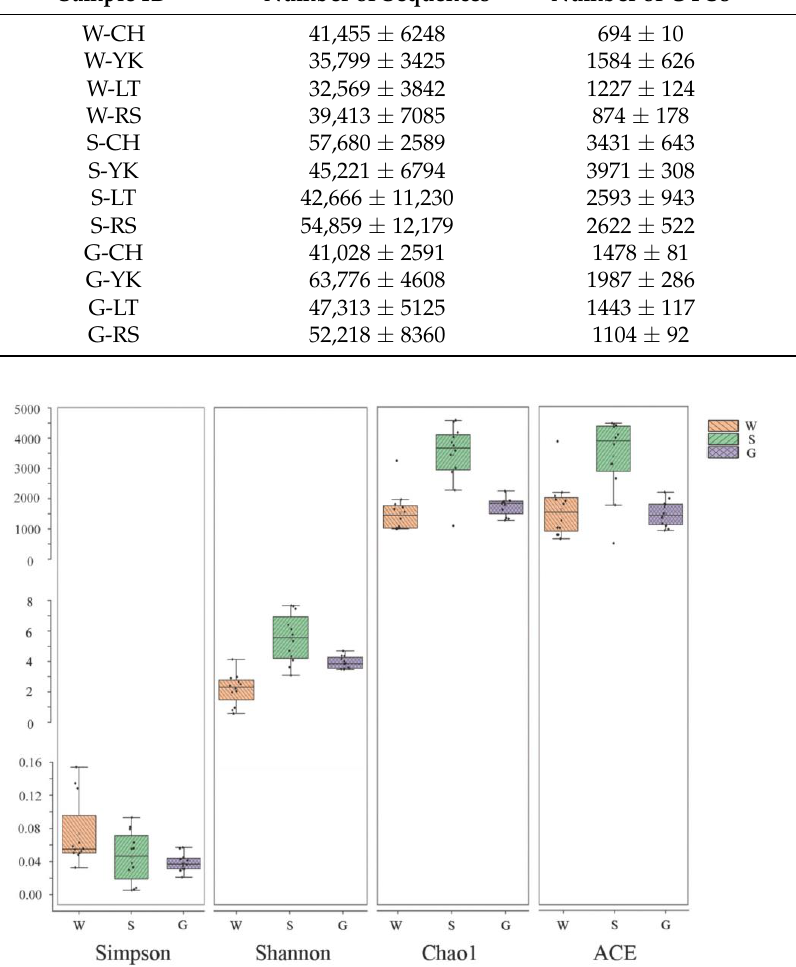
Figure 2. Alpha-diversity indices of bacterial communities among multiple media (water (W), sediment (S), and gut of Apostichopus japonicus (G)) in different areas. The Shannon index and Simpson index show differences in species diversity in multiple media between different areas, and Chao1 index and ACE index show differences in species richness in multiple media between different areas.